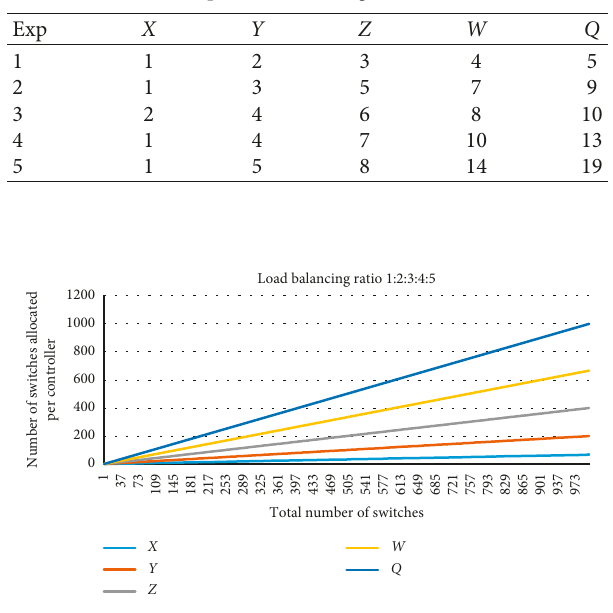
Figure 12: Load balancing for five slave controllers with ratios: 1: 2: 3: 4:5.